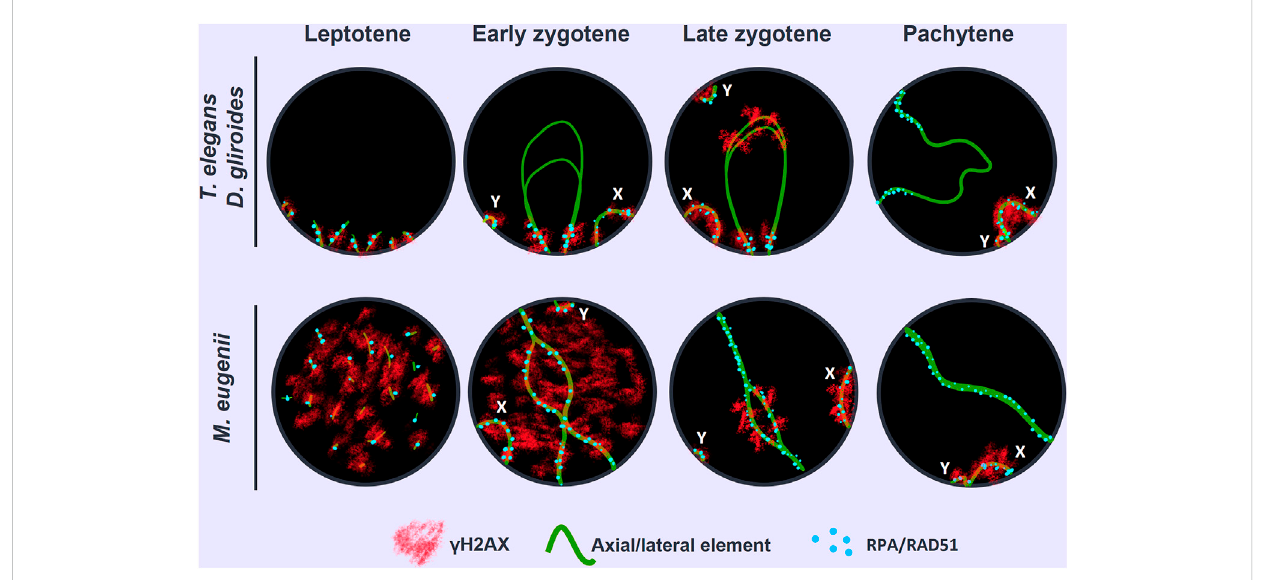
FIGURE 10 Schematic representation of the two different patterns of SC assembly, synapsis progression and DNA repair observed in the marsupial species. GreenlinesrepresentAE/LEs,redcloudsrepresent γ H2AXandbluespotsrepresentDNArepairproteins(RAD51/RPA).Ineachnucleusabivalentandboth sex chromosomes (X, Y) are represented. In the top row, the putative ancestral pattern involves: conspicuous bouquet polarization, AE assembly and synapsis progression from chromosomal ends and preferential localization of DNA damage and repair towards chromosomal distal regions. In the bottom row, the emergent pattern observed in Australian marsupials: loosened bouquet , AEs assembly and synapsis progression at any chromosomal position, and an even distribution of DNA damage and repair events along